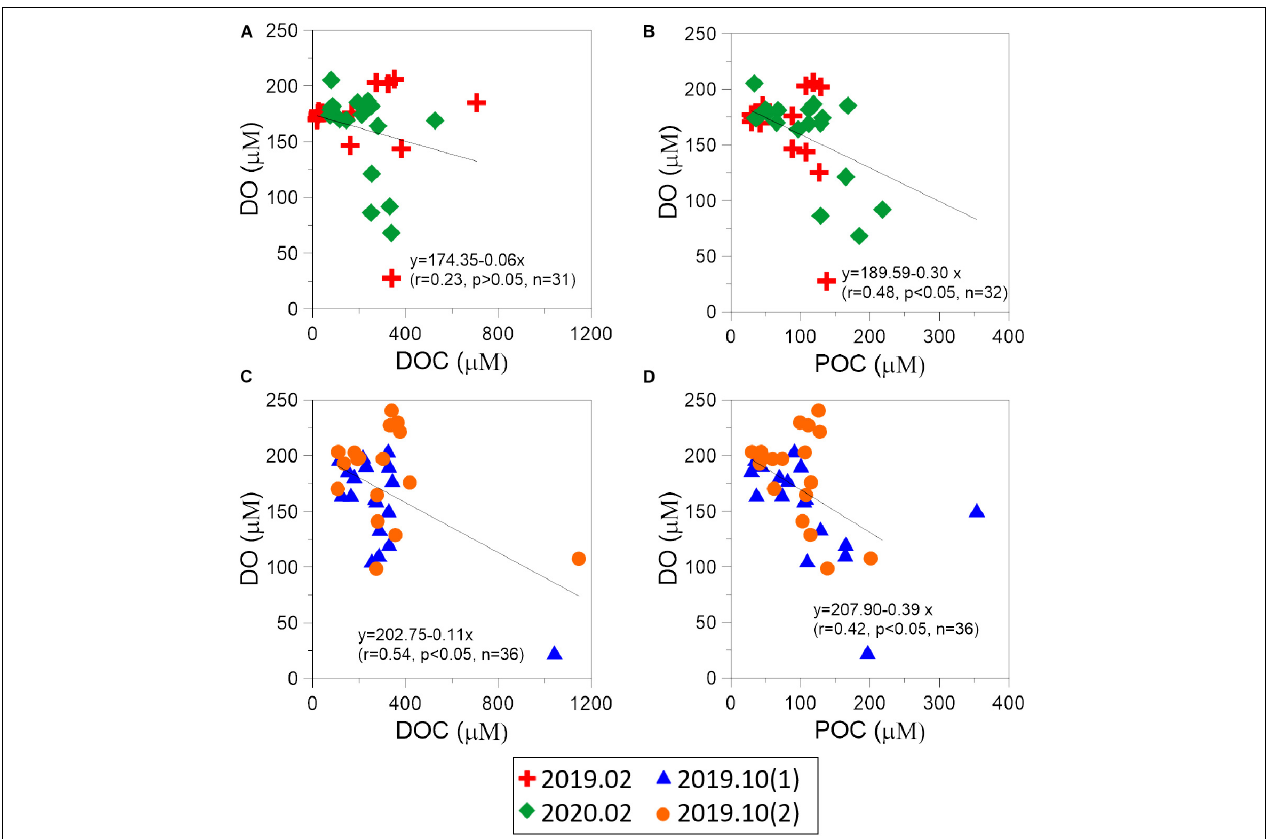
FIGURE 8 | The concentration of POC and DOC vs. DO in (A,B) dry season and (C,D) wet